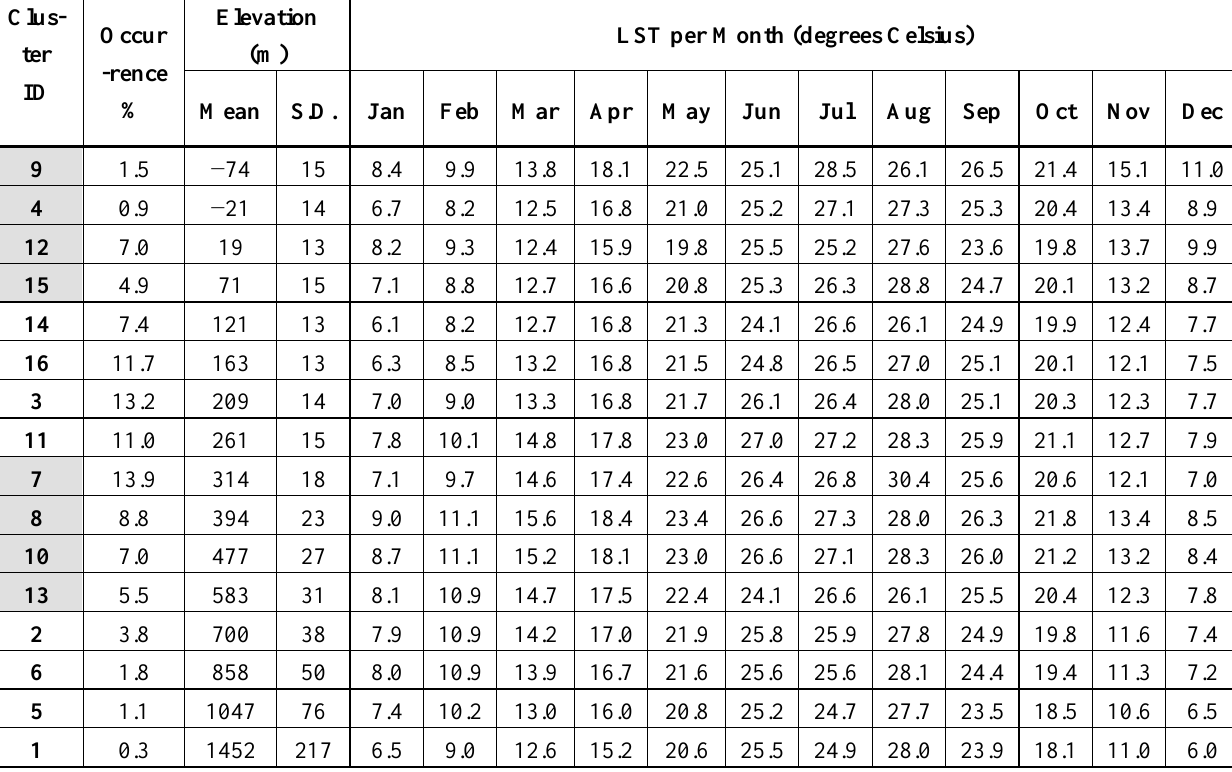
Table 2. Cluster occurrence and centroids (elevation and LST per month). Note that clusters were sorted in increasing mean elevation (negative mean elevation indicate clusters occupied by the Alexandria Lake).